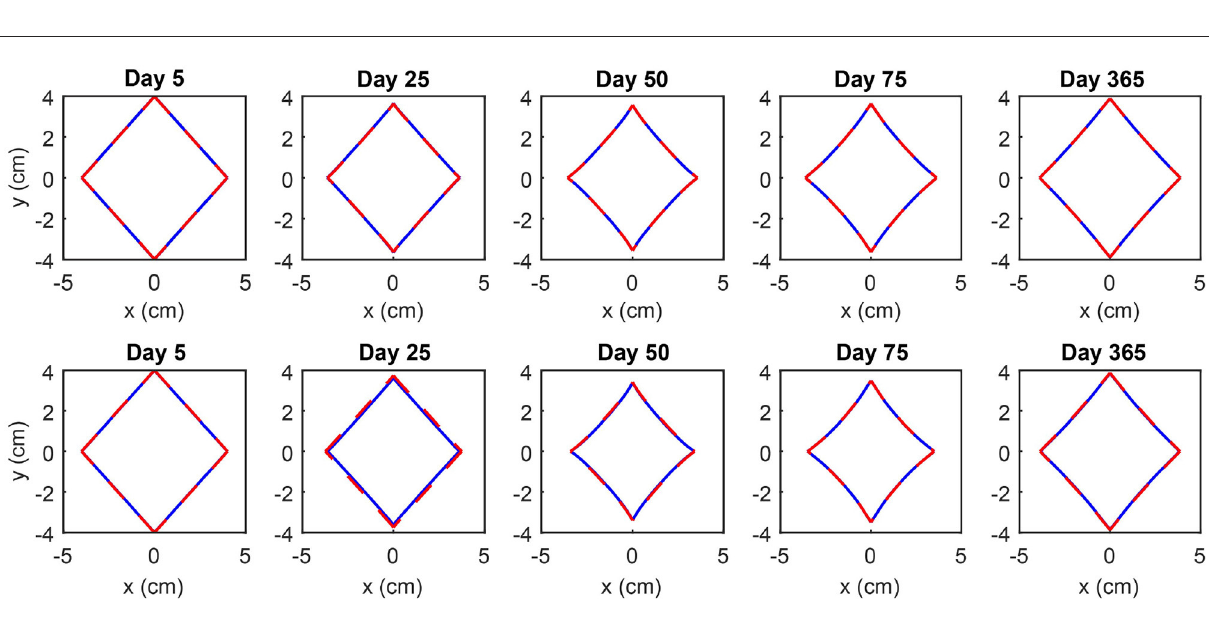
performance scores, the score for the asymptotic RSA is lower, though still above 99%, and the scores for minimum RSA and the maximum TSE are higher than the overall performance scores. The